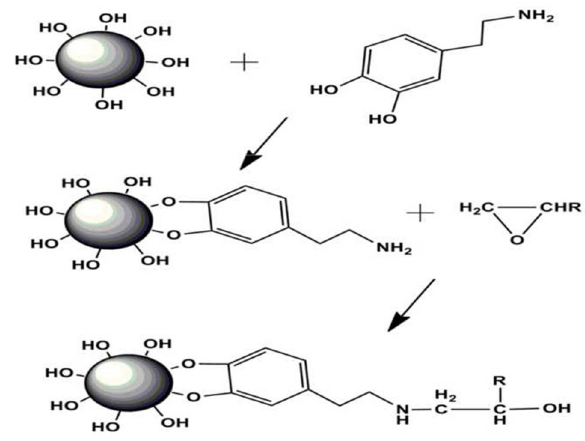
Figure 1. Mechanism of dopamine interaction with meso-TiO 2 and resin.